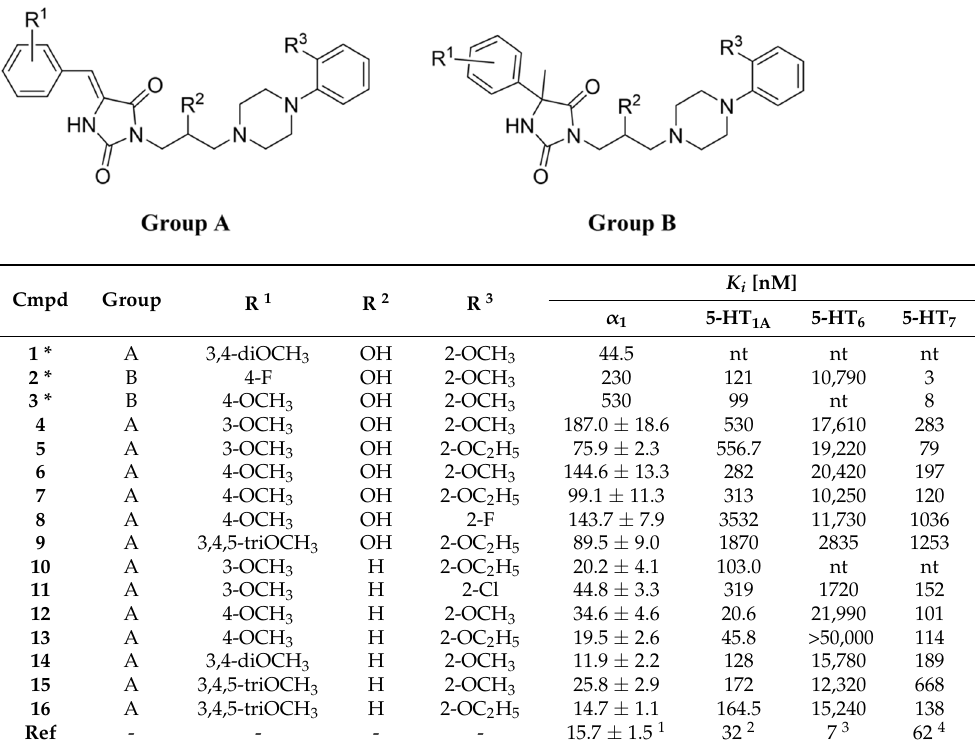
Table 2. Functional activity results of reference and tested compounds 10 , 12 , 14 and 16 at α 1A -AR in rat tail artery, at α 1B -AR in mouse spleen and at α 1D -AR in rat